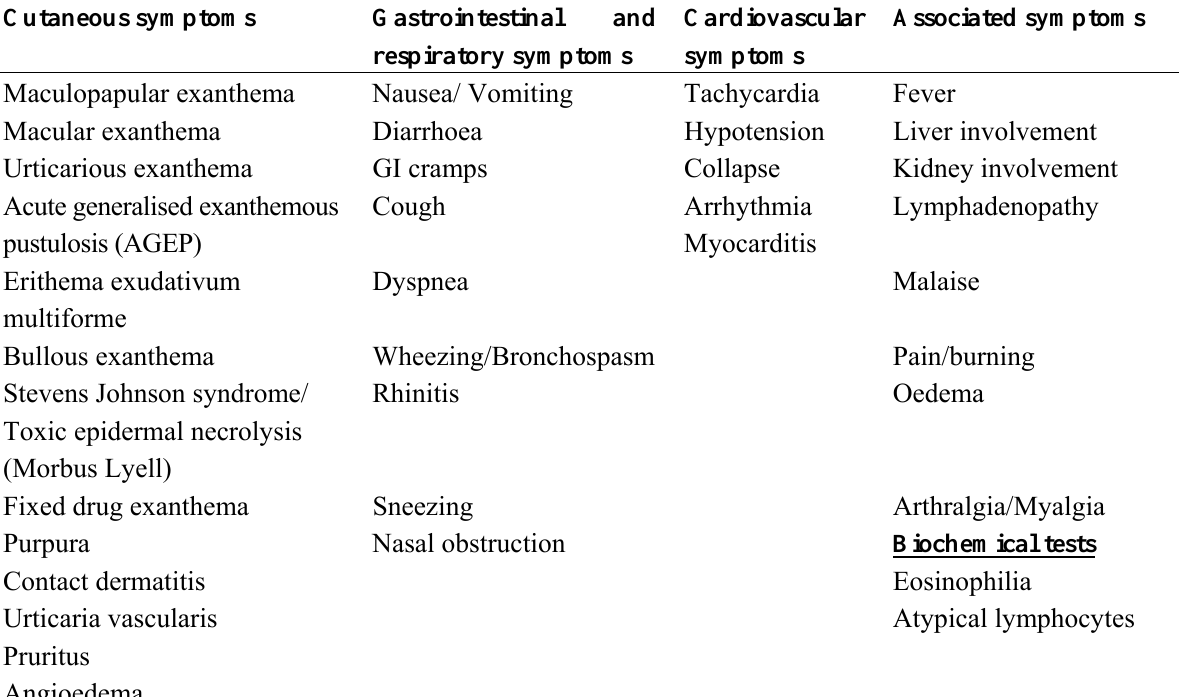
Table 4 . Clinical phenotype and symptoms of drug hypersensitivity (Adapted from ENDA (European Network for Drug Allergy) questionnaire)